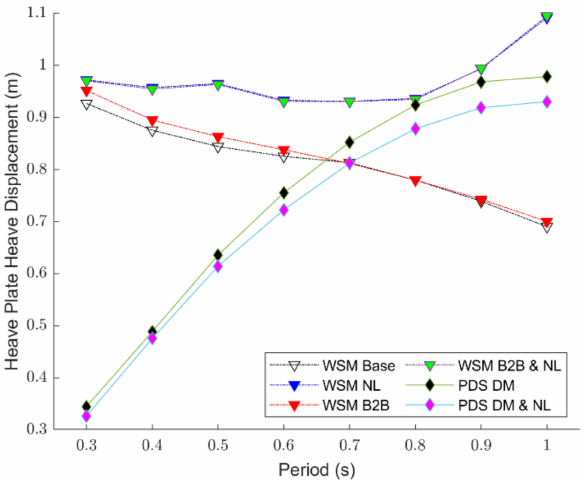
Figure 7. Maximum WEBS heave place heave displacement in regular